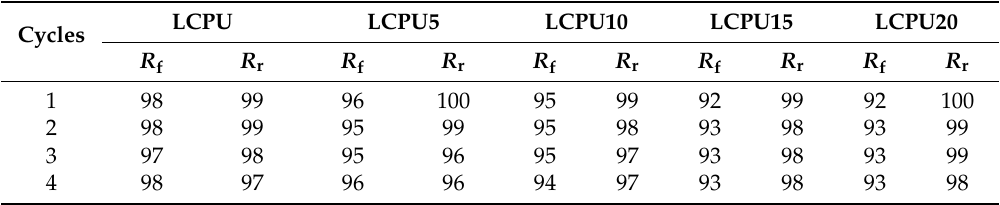
Figure 10. Recovery photos at different times of LCPU at first circle. Table 2. Shape fixity and shape recovery ratio of LCPU and GO/LCPU nanocomposites.